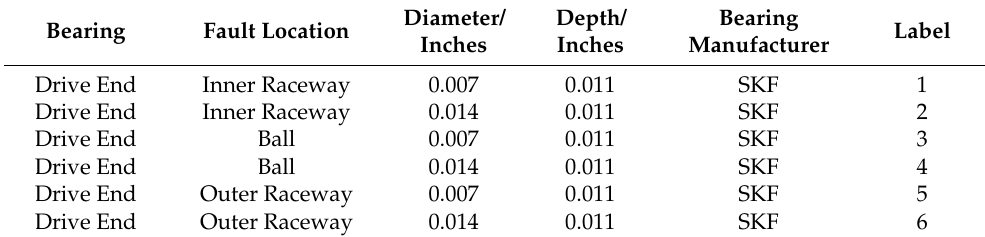
Table 6. Bearing fault description in CWRU dataset.